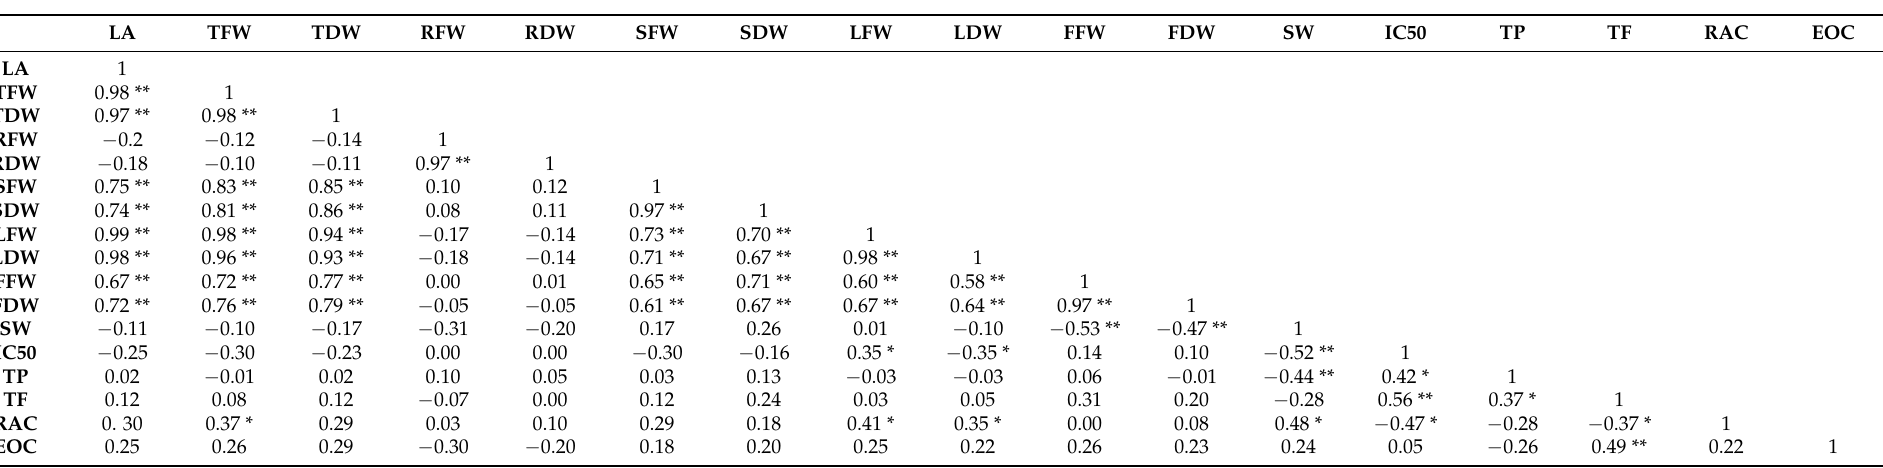
Table 5. Pearson’s correlation coefficient of various agronomical and biochemical traits studied among Salvia species 1